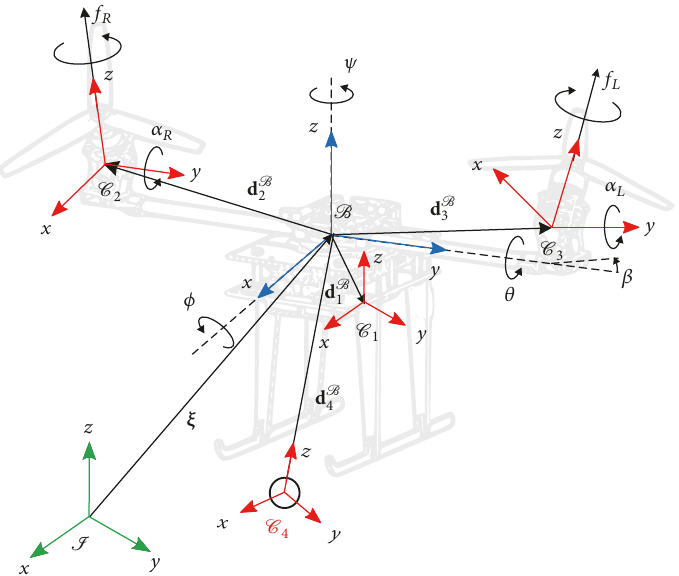
Figure 1: Tilt-rotor UAV frames and variables